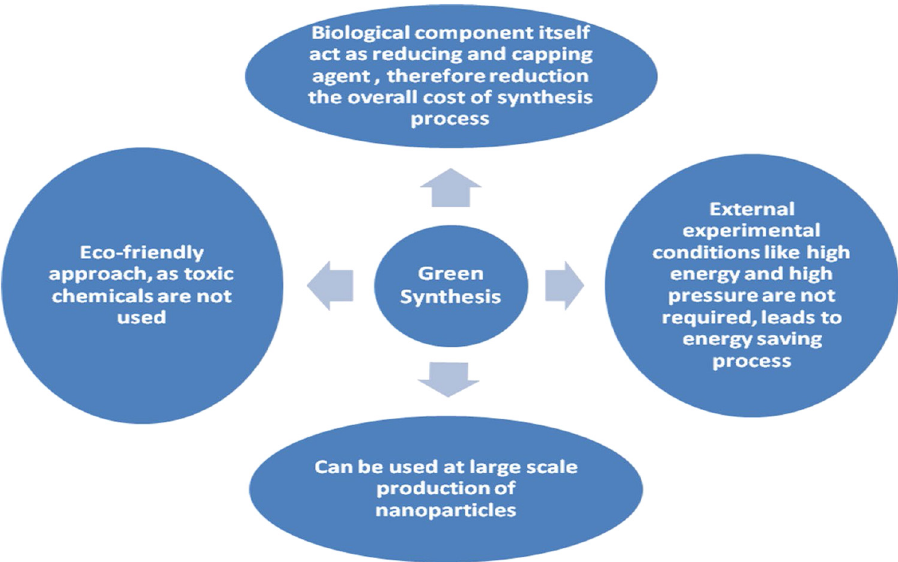
Figure 1: Key merits of green synthesis [ 26 ]